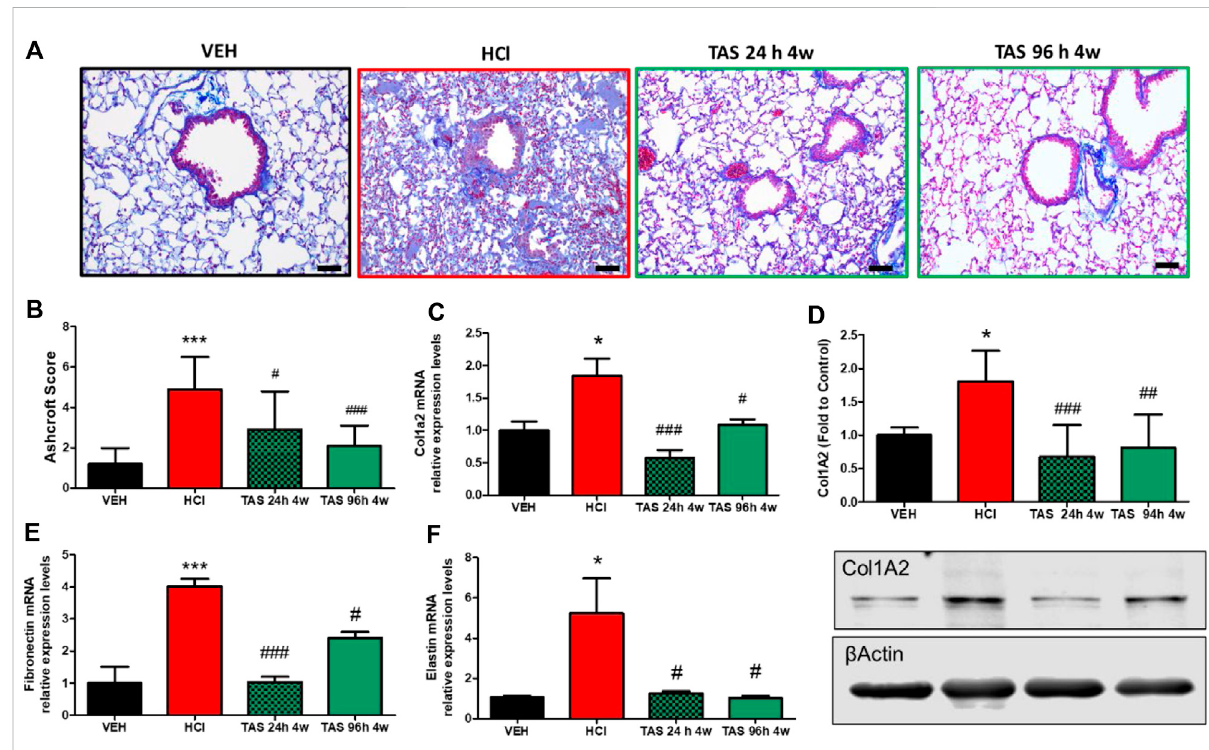
Oral treatment with TAS-116 — starting either 24 or 96 ° h after HCl-ameliorates HCl-induced pulmonary fi brosis. Mice were intratracheally instilled with 0.1N HCl or saline followed by treatment, starting 24 or 96 h later, with the HSP90 inhibitor TAS-116 (7 mg/kg 5×/week p. o.) for 4 ° weeks. Masson ’ s Trichrome staining of lung sections demonstrates massive fi brous obliteration and loss of parenchymal architecture in HCl- instilled mice (A) . The Ashcroft score depicts severe fi brosis in HCl-instilled mice and recovered lungs in TAS-116-treated groups of mice (B) . The level of collagen type I was indicated via qPCR (C) and Western Blotting (D) . mRNA expression of extracellular matrix Fibronectin (E) and Elastin (F) weremeasured via qPCR.Originalmagni fi cation×20;blackscalebarscorrespondto50 µm(Means±SEM; n =4 – 6;*: p < 0.05,***: p <